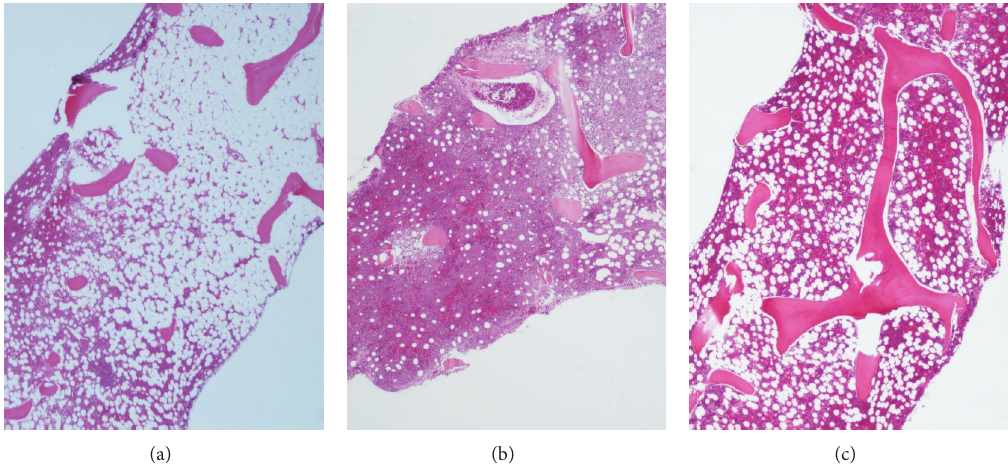
Figure 1: MGG stained bone marrow biopsies before (a), at 3 months (b) of, and at 12 months (c) of treatment (magnification × 10).